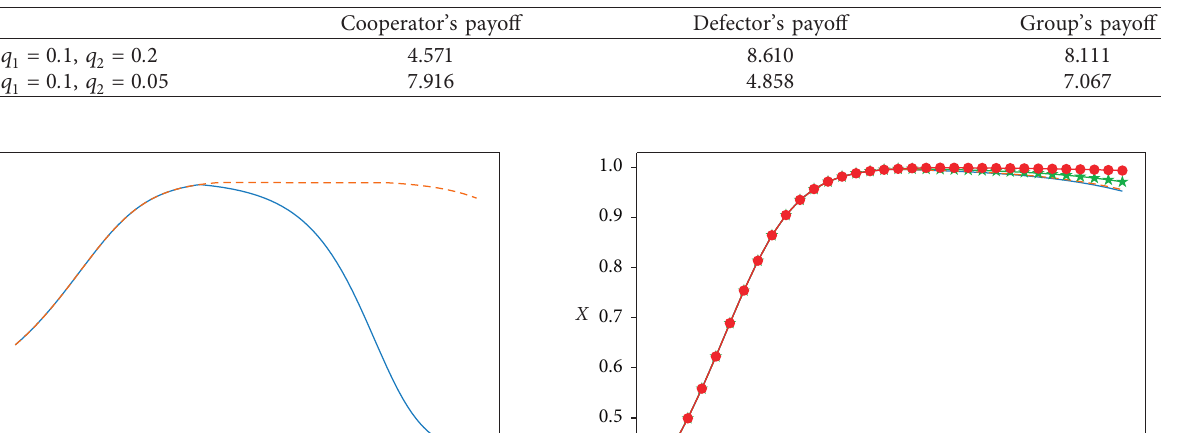
Table 2: The payoff of the cooperator, defector, and group with SC.